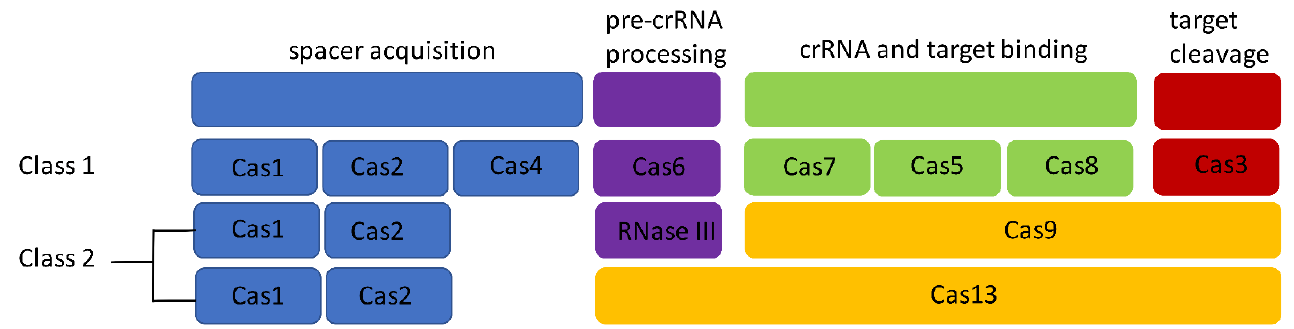
Figure 1. Composition of Class 1 and Class 2 clustered regularly interspaced short palindromic repeat (CRISPR) systems. Cas9 and Cas13 are the same color signifying they both perform multiple functions as indicated by their spanning multiple functional blocks.